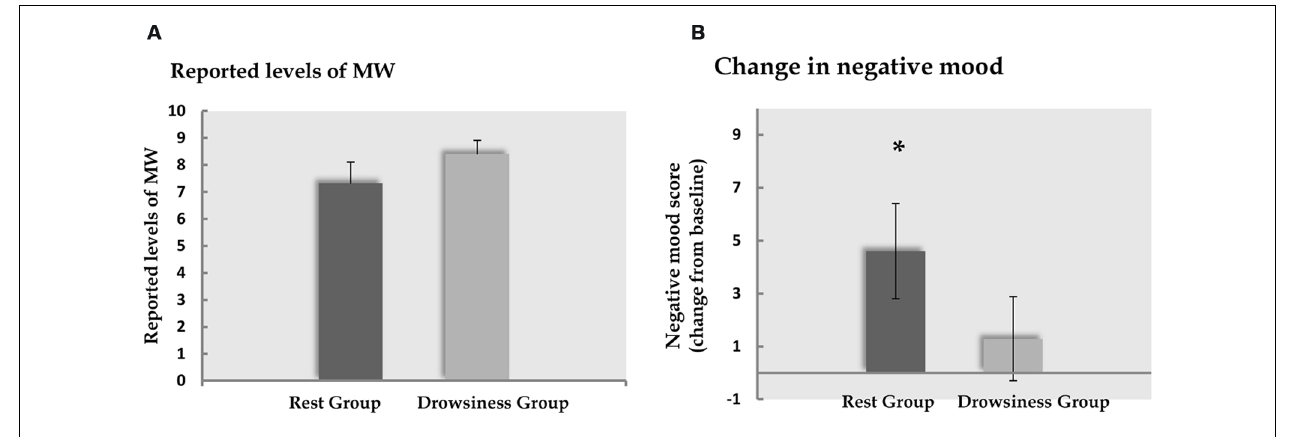
FIGURE 3 | Behavioral results. PanelA demonstrates the degree of MW reported by participants to occur during the 15-minute rest scan. Panel B demonstrates the change (mean and standard error) from baseline in reports of negative affect following the 15-minute rest scan. Dark column